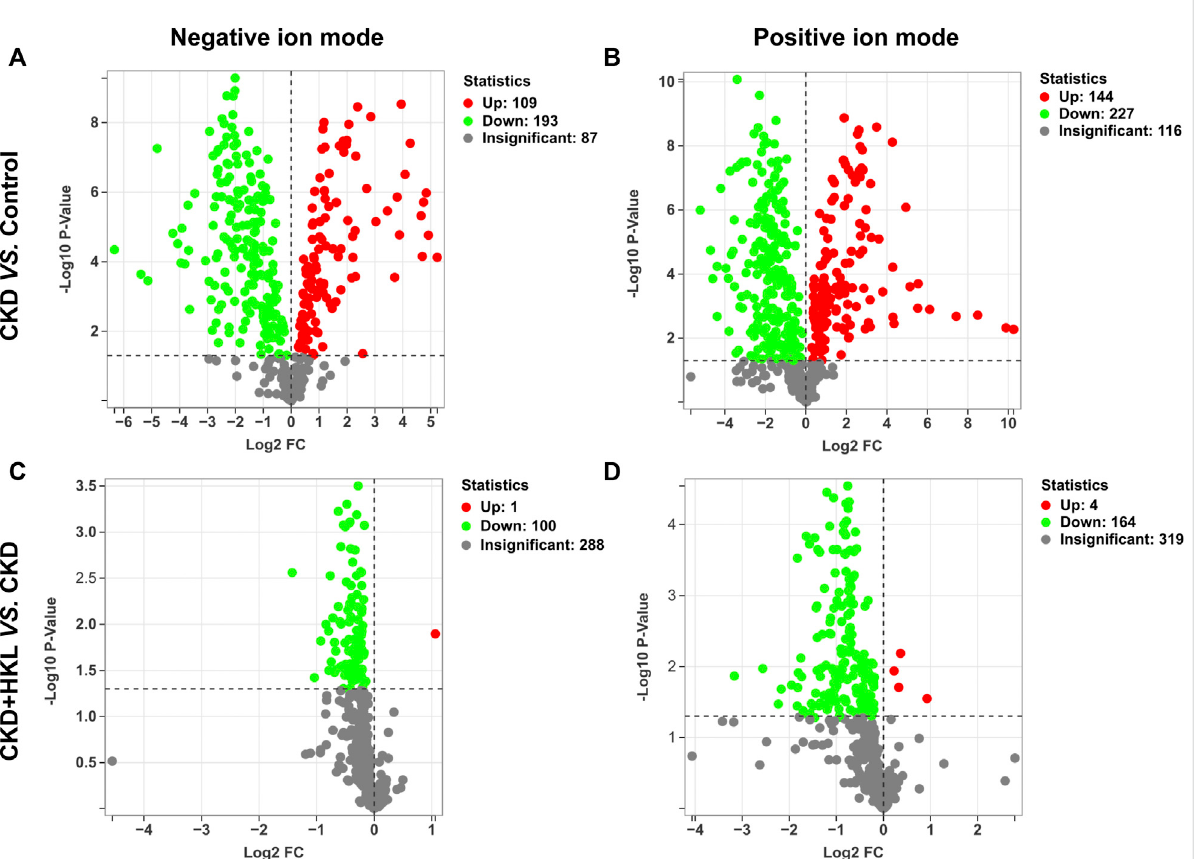
FIGURE 6 Volcano plots of lipid differences between groups. (A) Differential lipid pro fi les in CKD versus control in negative ion mode. (B) Differential lipid pro fi les in CKD versus control in positive ion mode. (C) Differential lipid pro fi les in CKD + HKL versus CKD in negative ion mode. (D) Differential lipid pro fi les in CKD + HKL versus CKD in positive ion mode. The red dots represent signi fi cant upregulation, the green dots represent signi fi cant downregulation, and the grey dots represent insigni fi cant.